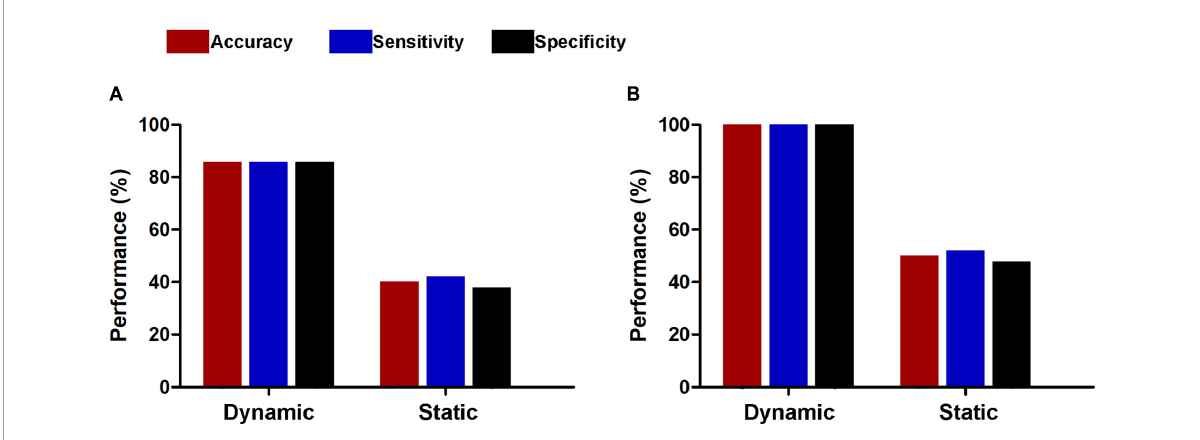
FIGURE7 Classification performances of dynamic and static functional connectivity-based classifiers using AAL atlas with 116 nodes (A) and Random atlas with 1,024 nodes (B)